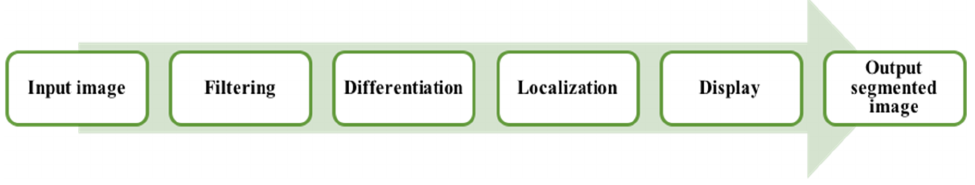
Figure 8. Overall process of edge-based segmentation.